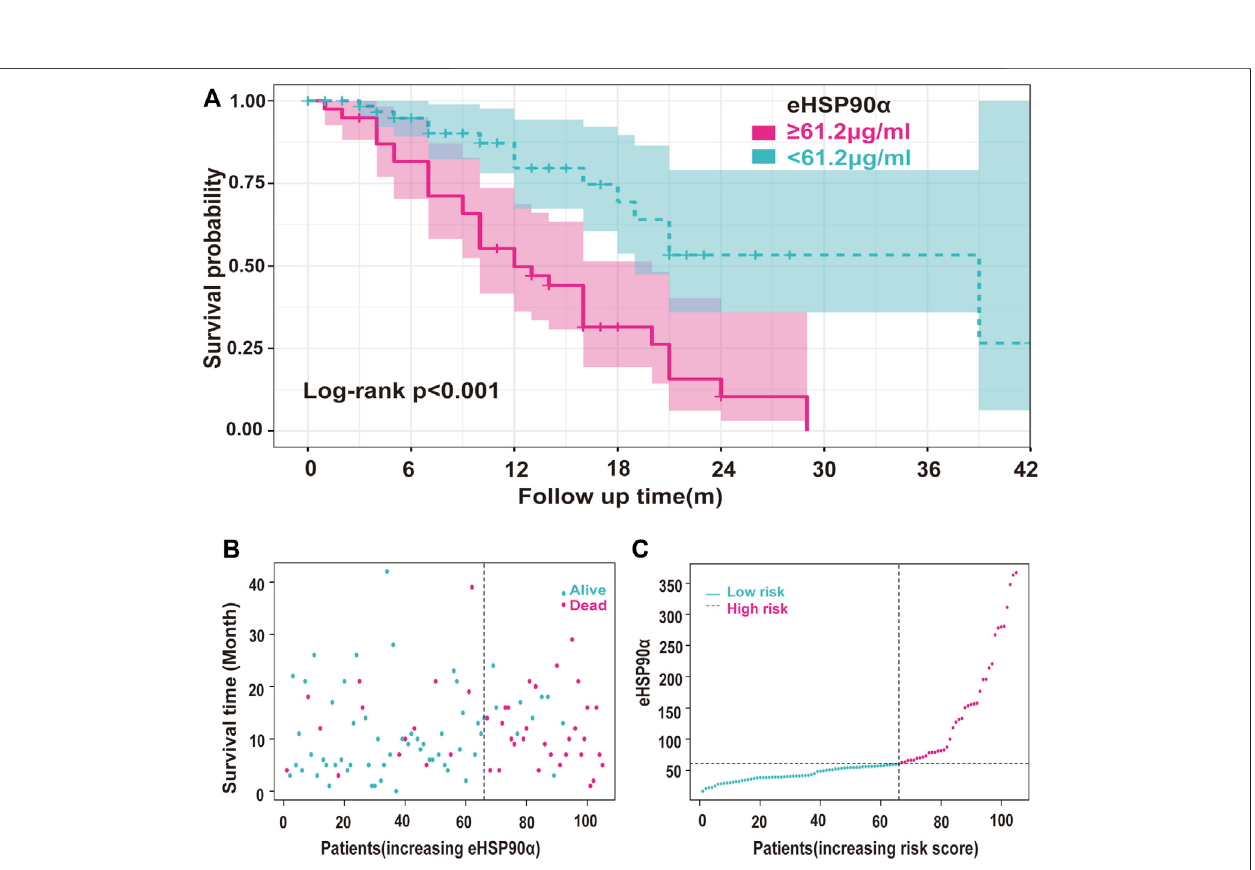
FIGURE5| Survivalanalysisofthe relationship between eHSP90 α and OSinSCLC (A) Kaplan-Meier survivalcurves oftheSCLC patients divided intotwogroups with61.2 ng/mLasthecut-offvalue (B) Usethesurvivaltimemodeltobuildascatterplotofriskscoreandsurvivaltimeandcolor-codedsaidscatterplot.Incontrast,red is for death, and blue is for survival based on the outcome (C) The survival time model was used to build a risk line graph, and patients are ranked high to low risks. The ordinate was the expression of eHSP90 α , and the dotted line was the median value to distinguish between high and low stakes. Red indicates high risk, and blue indicates low